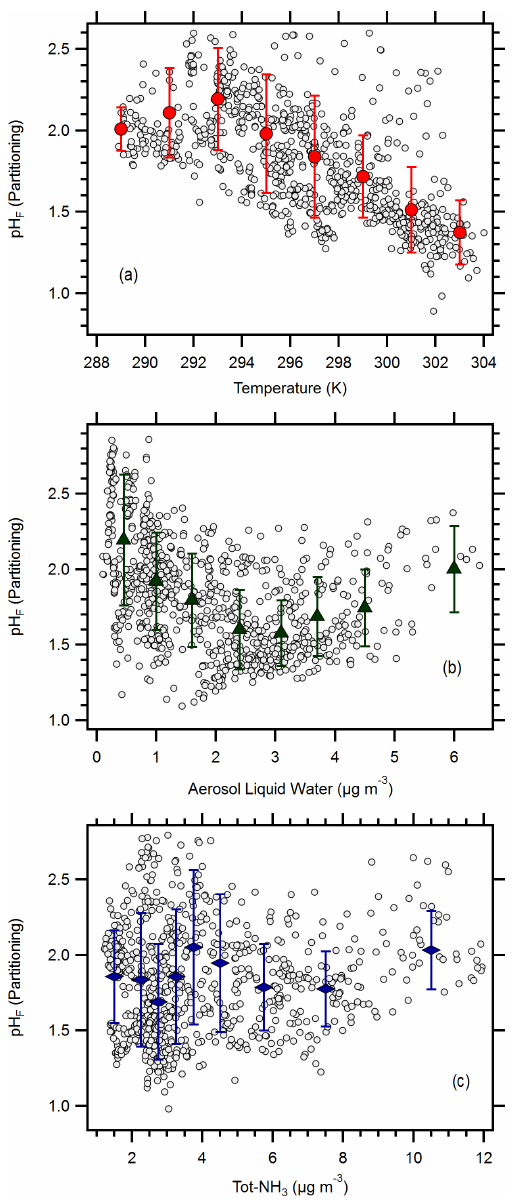
Figure 4. Relationship between aerosol pH and (a) tem- perature, (b) aerosol liquid water, and (c) total NH 3 (Tot- NH 3 = NH 3 + NH + ). Symbols represent mean values, while error 4 bars represent standard deviations; bins were limited to a maximum of 160 points per